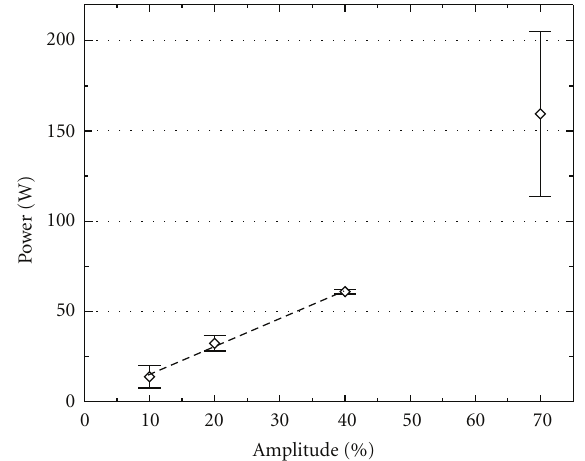
Figure 12: Horn transducer power consumption as a function of tip amplitude.